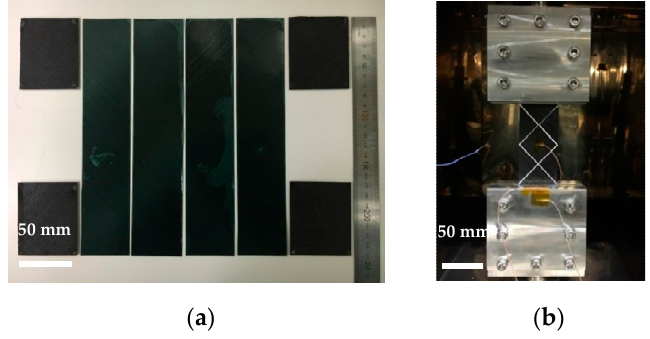
Figure 1. ( a ) Sample preparation and ( b ) test apparatus for the bias extension test.